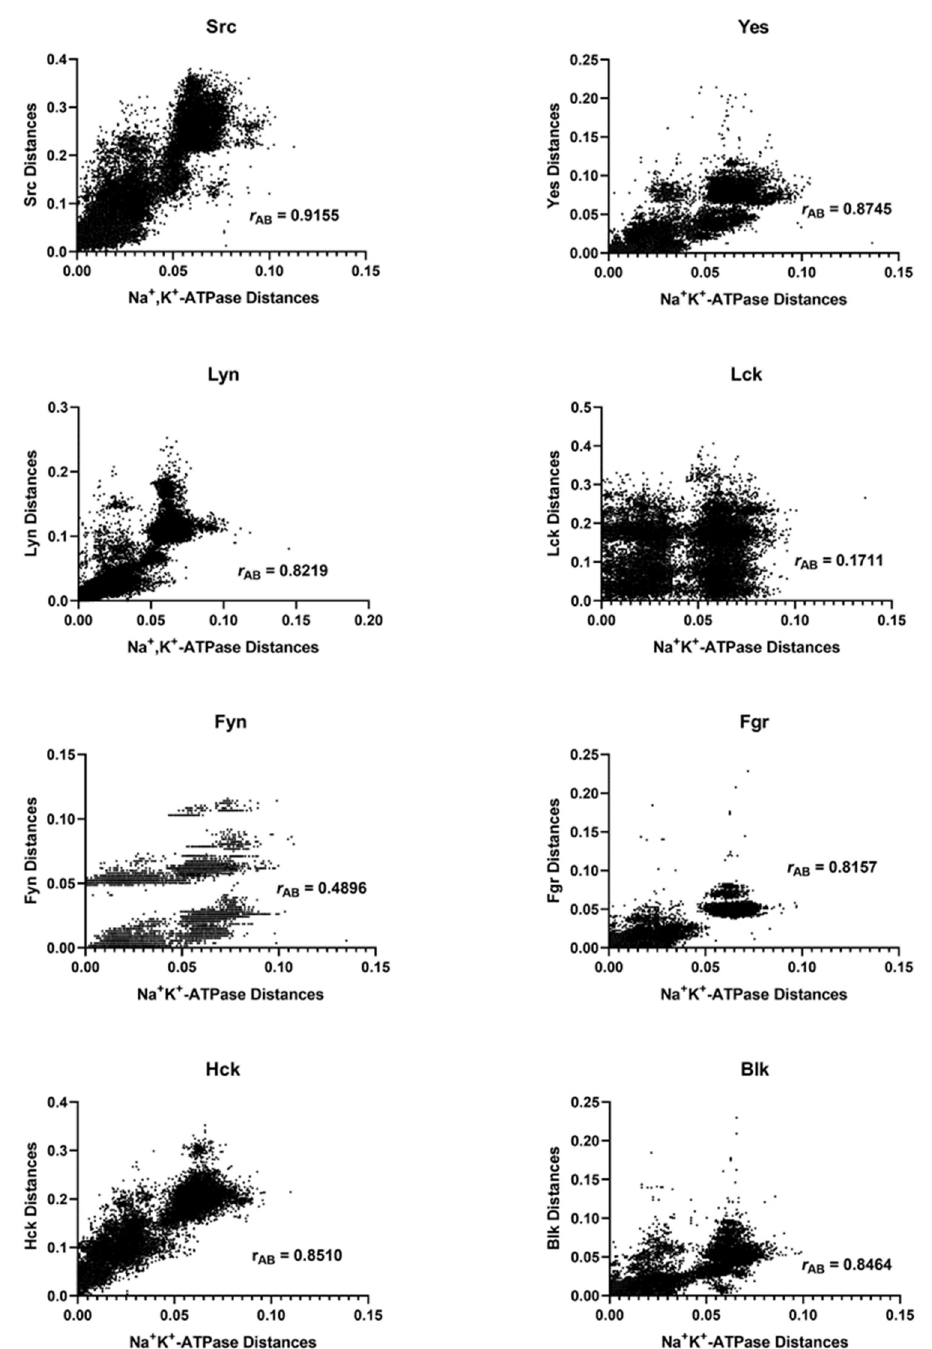
Figure 3. Correlations of evolutionary distances between common organisms that express different members of the Src kinase family of enzymes and the Na + , K + -ATPase α 1